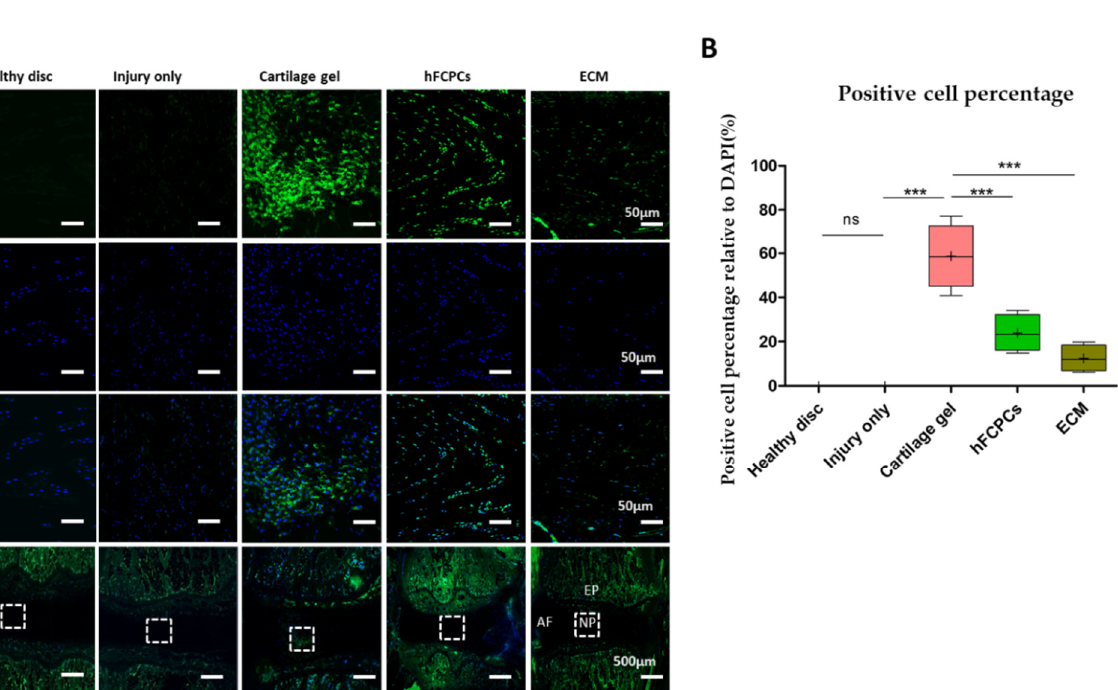
Figure 5. Preservation of implanted cells in the disc nucleus pulposus (NP) of a rat tail nucleotomy model. ( A ) Immunofluorescence of rat tails in the cartilage gel-injected, hFCPCs-injected, ECM-injected, healthy, and injury-only discs at six weeks after nucleotomy for human nuclei antigen (green), DAPI (blue), and merged signals. ( B ) Changes in the percentage of human nuclear antigen- positive cells. Immunopositivity was counted in the disc NP with low-power fields and calculated as relative to the total number of DAPI-positive cells. Data are presented with box plots (n = 4, *** p < 0.001, ns, not significant, significant difference by one-way ANOVA). hFCPCs, human fetal cartilage- derived progenitor cells; ECM, extracellular matrix.